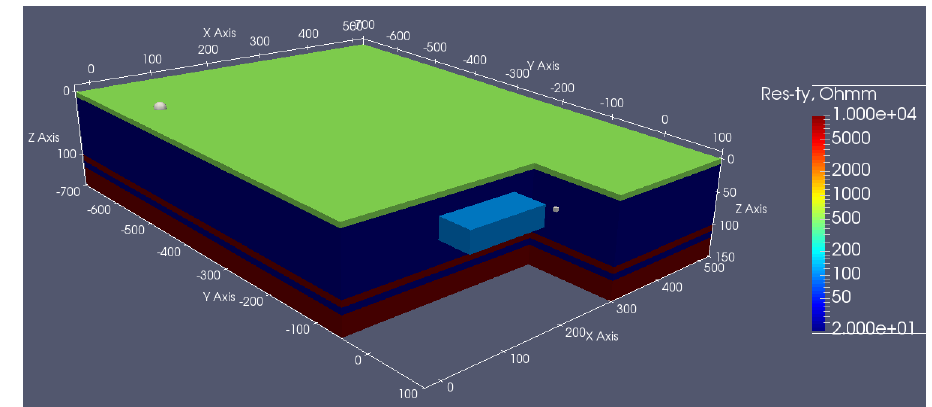
Figure 3. The 3D model used for benchmarking. The grey cube depicts position of the receiver station. The sphere is placed at transmitter position.